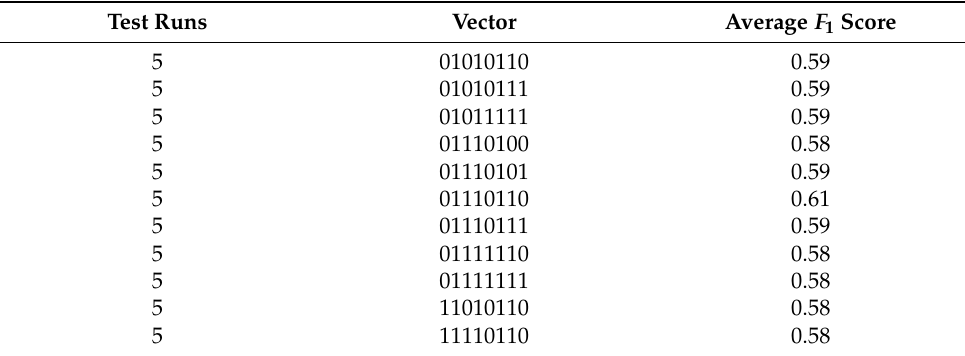
Table 4. Zeus/ISFB Highest Performing Feature Combinations.